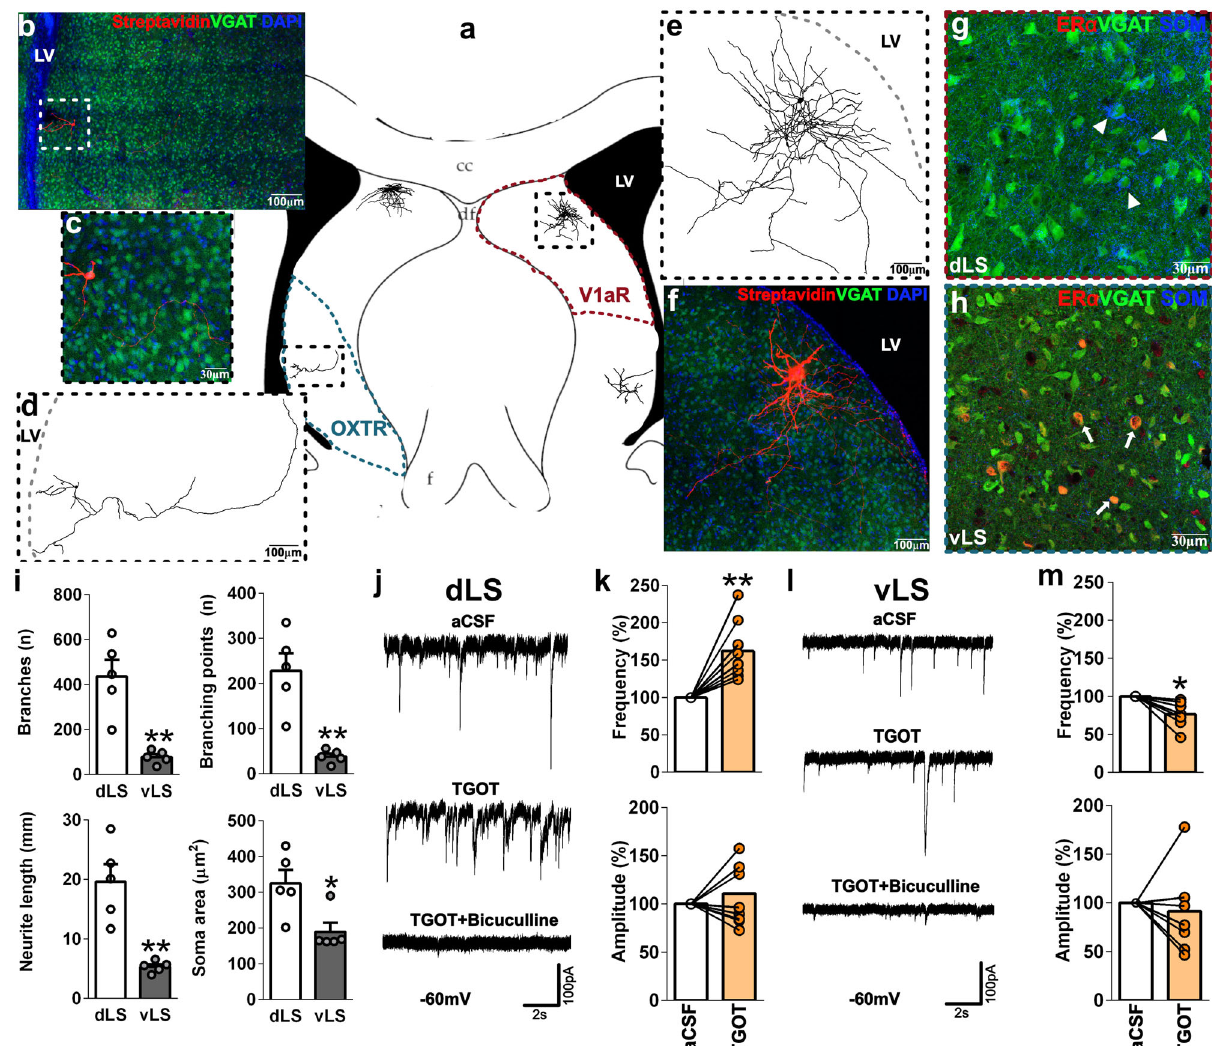
Fig. 6 Spontaneous activity in neurons of the dLS and vLS is differentially modulated by activation of OXTRs. a Scheme indicating the receptor binding- speci fi c delimitation of the vLS (OXTR) and dLS (V1aR) used during voltage-clamp experiments, including two representative dLS and vLS cells. b Maximal z-projection of biocytin- fi lled vLS cell (streptavidin-CF633) overlaid with a single z-plane of VGAT and DAPI. c Magni fi cation of cell body from the cell shown in b . d Neurite reconstruction of cell shown in b , and e of the cell shown in f ; the gray-dotted line indicates the border of the lateral ventricle (LV). f Maximal z-projection of a biocytin- fi lled dLS (streptavidin-CF633) cell overlaid with a single z-plane of VGAT and DAPI. g Magni fi cation of a single z- plane indicating the presence of somatostatin (SOM) cell bodies (arrowheads) only in the dLS. h Magni fi cation of a single z-plane indicating the presence of ER α -positive cell bodies (arrows) only in the vLS. i Morphological characterization of LS neurons. dLS cells exhibited more neurite branches (two-tailed Student ’ s t test t (4) = 4.84, p = 0.0072) and branching points ( t (4) = 4.85, p = 0.0072) longer neurite length ( t (4) = 4.80, p = 0.0078), and wider soma areas (Mann – Whitney U test U = 1.0, p = 0.016) than vLS cells. Representative spontaneous current traces during TGOT (1 µ M) and bicuculline (50 µ M) bath application in dLS j and vLS l cells. k TGOT increased sIPSC frequencies in dLS cells (Wilcoxon signed-rank test W (9) = 55, p = 0.002) and m decreased sIPSC frequencies in vLS cells ( W (7) = − 36, p = 0.0078). TGOT had no effect whatsoever on the sIPSC amplitude independent of the subregion. Data are shown as mean + SEM. * p < 0.05, ** p < 0.01, vs either dLS or aCSF. Morphology: n = 5; electrophysiology: dLS n = 10, vLS n =